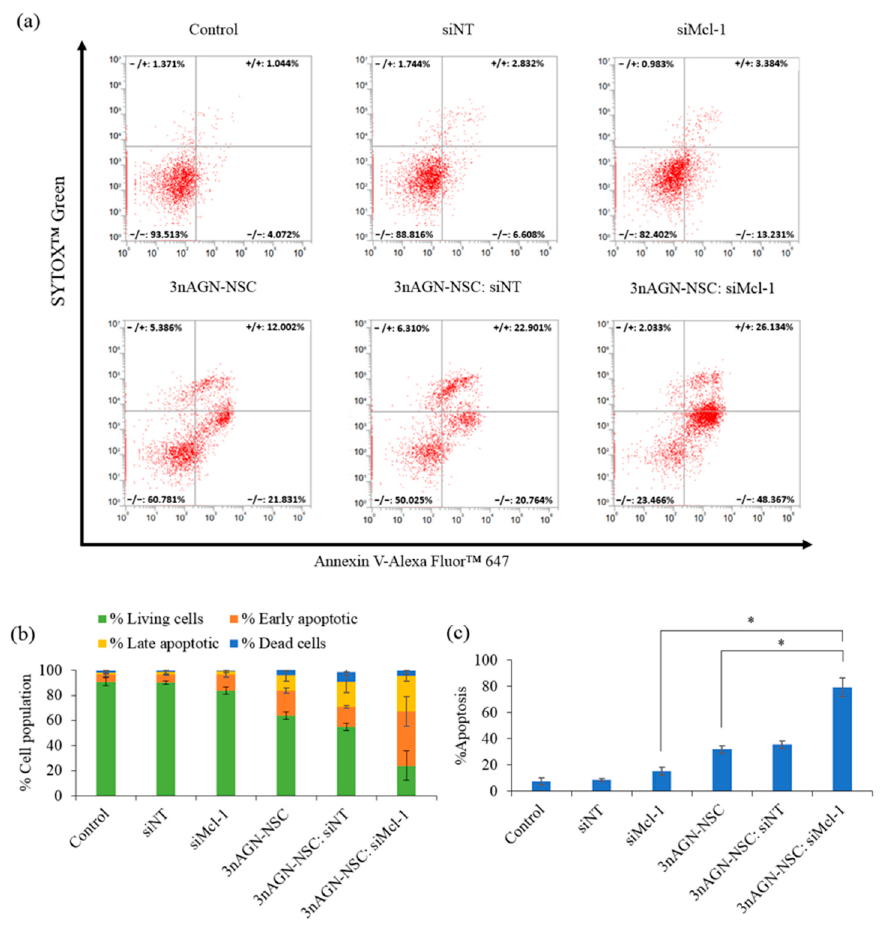
Figure 6. Apoptosis profile of MCF-7 cells analyzed by a flow cytometer. The cell was treated with 3nAGN (10.71 µM), siMcl-1 (0.075 µM), siNT (0.075 µM), 3nAGN-NSC:siNT (10.71 and 0.075 µM), or 3nAGN-NSC:siMcl-1 (10.71 and 0.075 µM) for 24 h and stained with Annexin V-Alexa Fluor ™ 647/SYTOX ™ Green. ( a ) Representative scatter plots of SYTOX™ Green (y-axis) vs. annexin V (x-axis). ( b ) Percentage of living, early apoptotic, late apoptotic, and dead cells. ( c ) the percentage of apoptosis. * The data are significantly different ( p < 0.05).